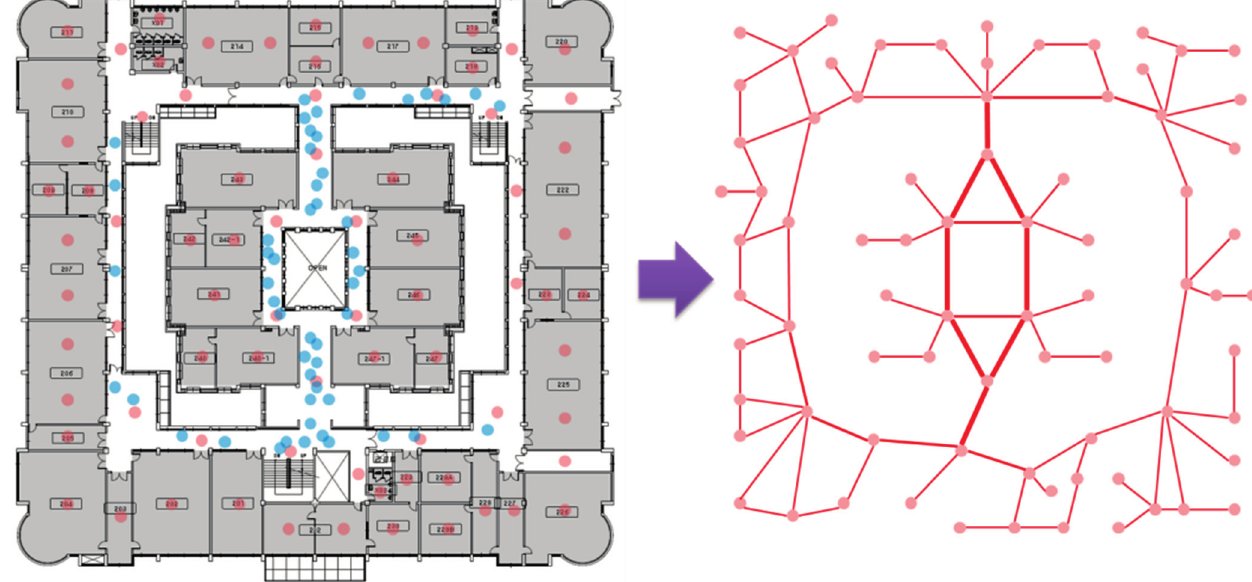
Figure 9. Dynamic map based on the movement of mobile users in the proposed overlay